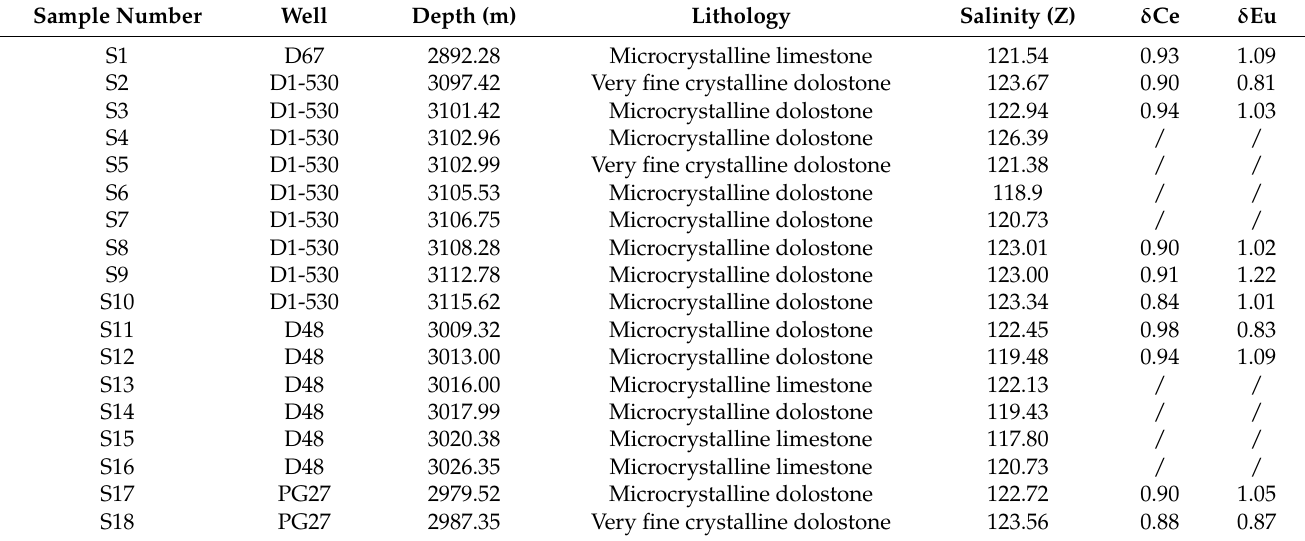
Table 6. Salinity and Calculation results of REE.